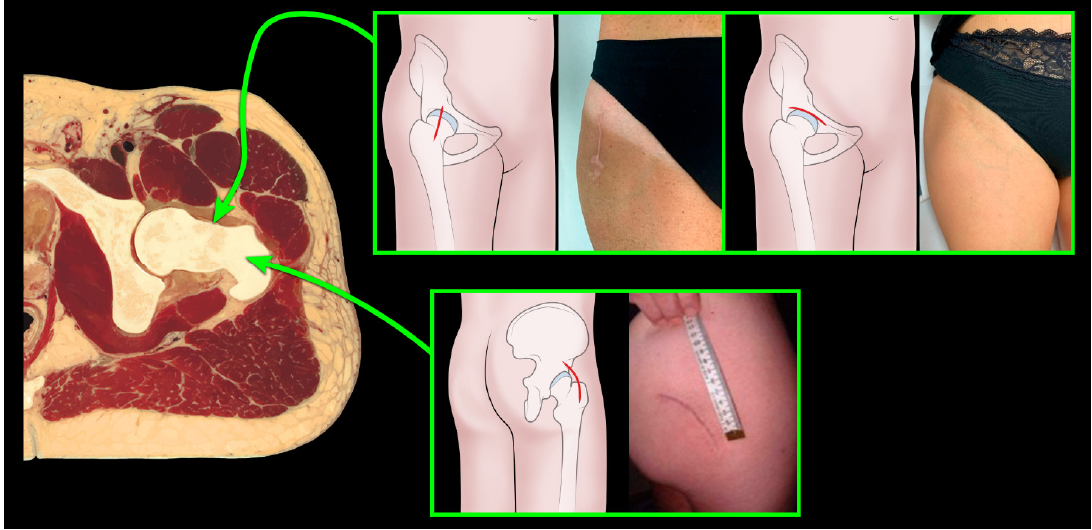
Figure 1. Pelvic transverse section with anterior and posterior approach, divided to incision: Bikini, direct anterior and